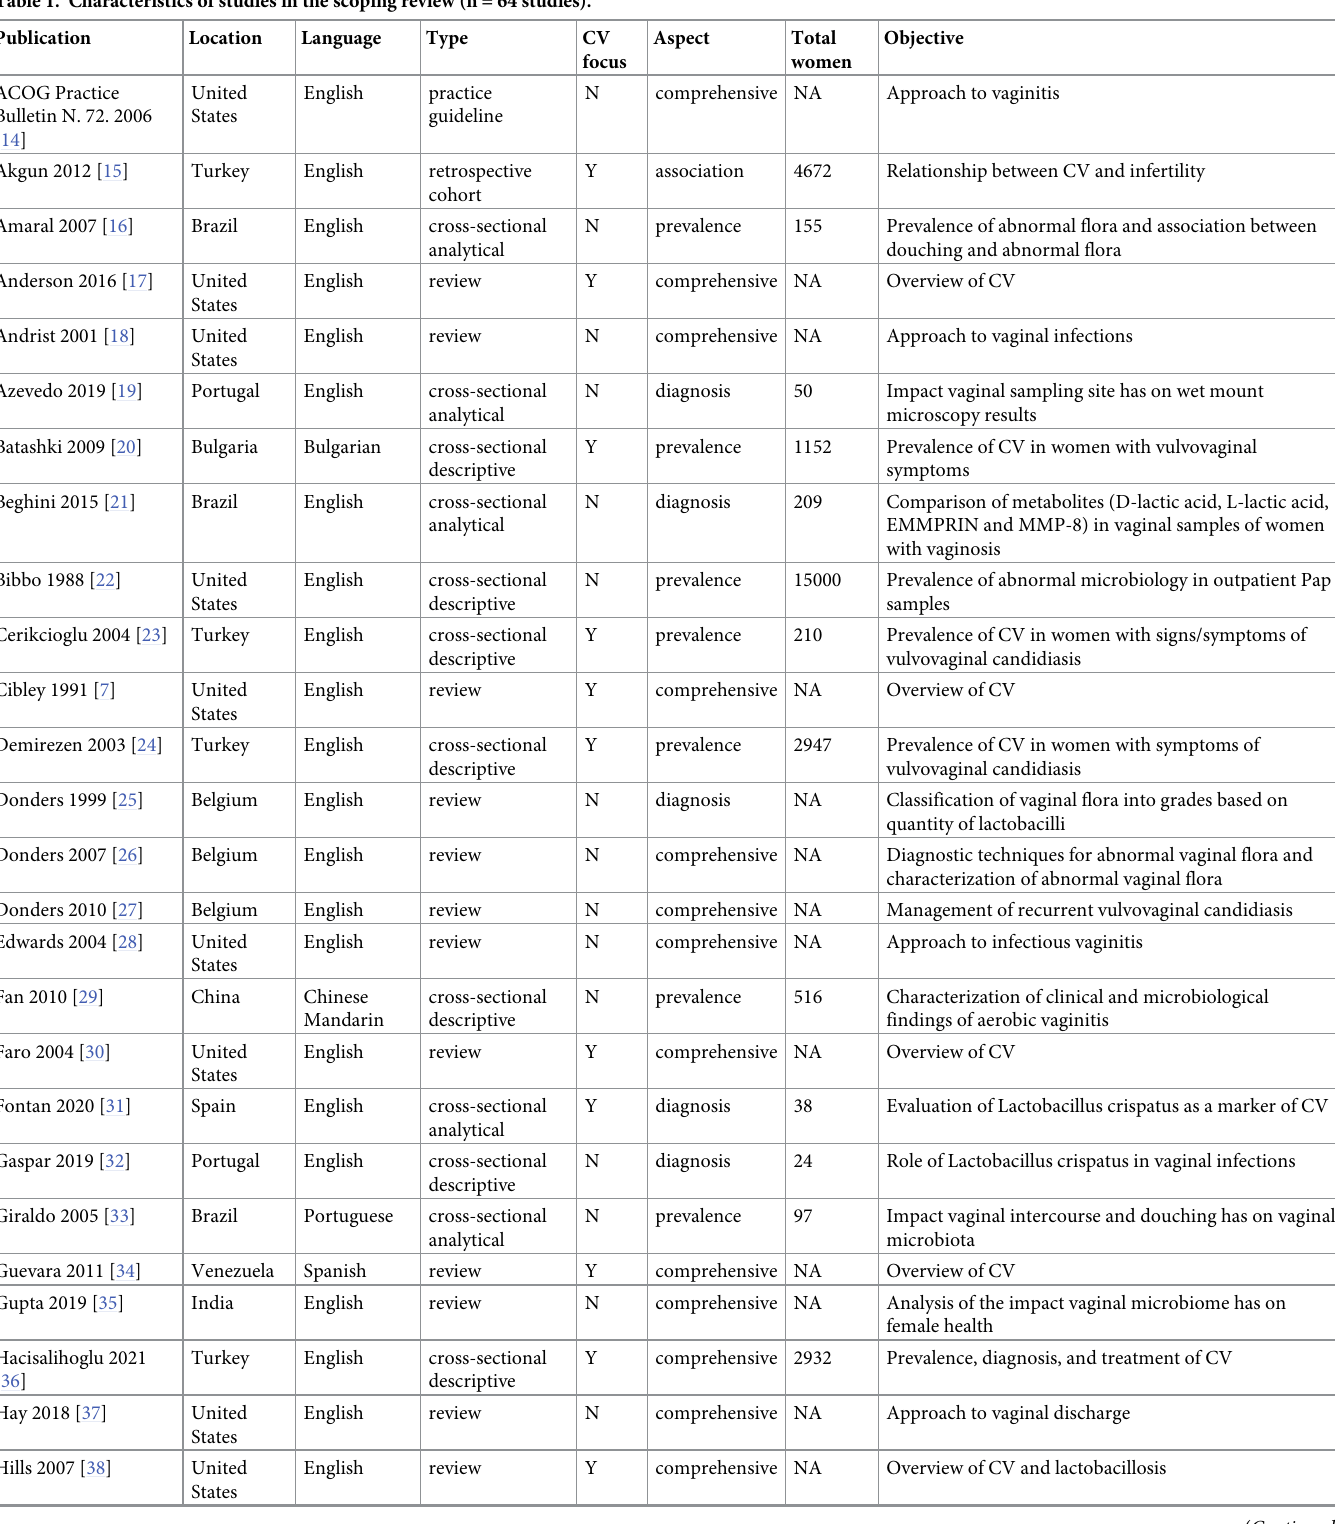
Table 1. Characteristics of studies in the scoping review (n = 64